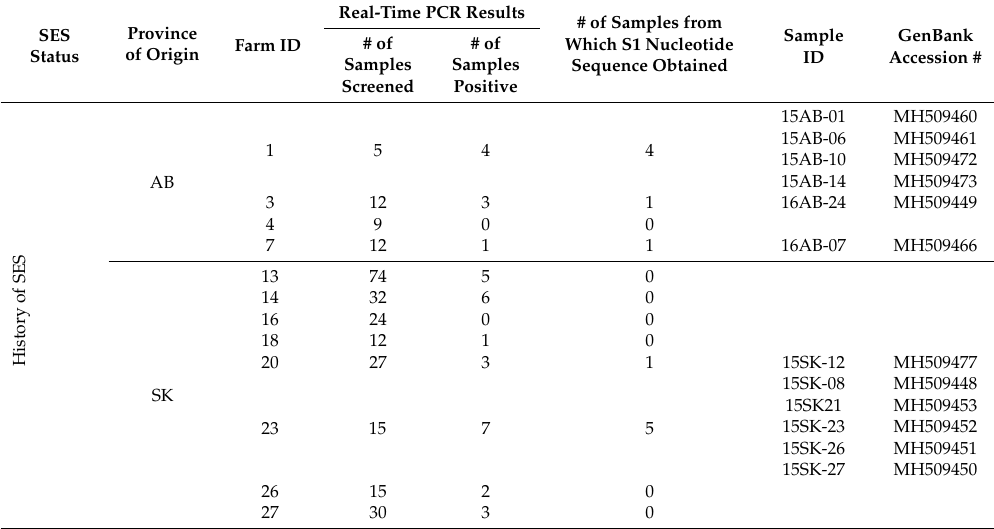
Table 1. Summary of the tissue screening results for IBV genome (AB = Alberta, SK = Saskatchewan, # =